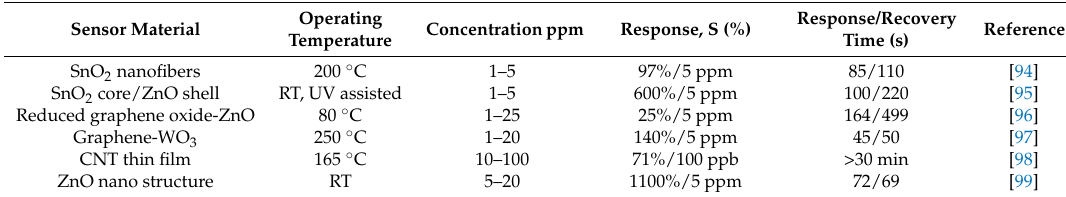
Table 5. The NO 2 sensors fabricated with different materials.